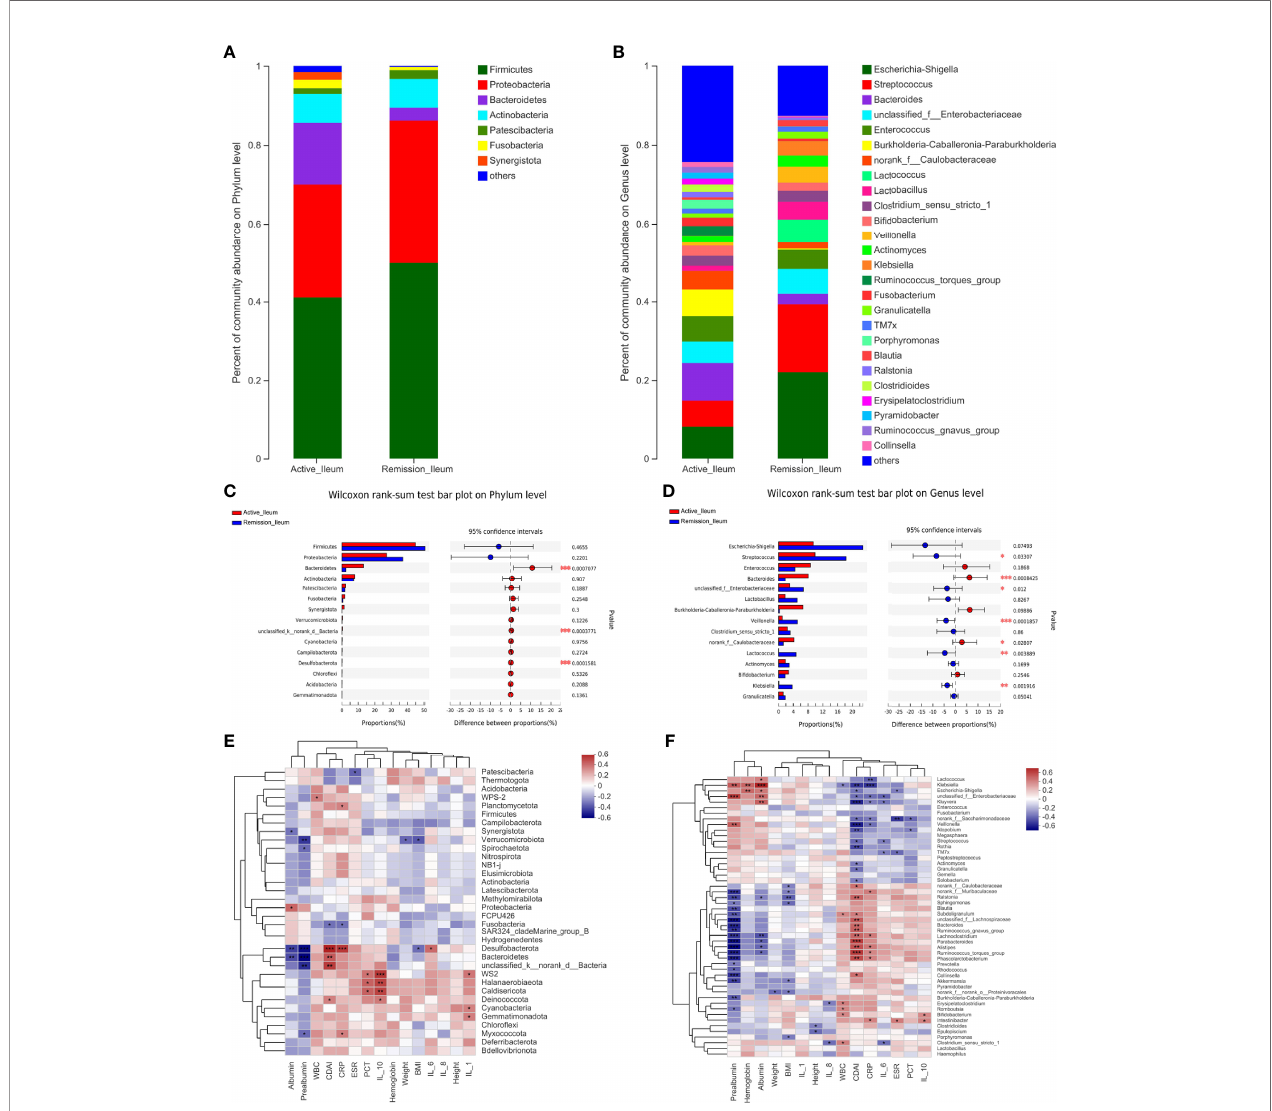
FIGURE 7 | Structure analysis of the ileal microbiota in patients with CD. (A, B) Barplot of the relative abundances of different taxa on the phylum and genus levels, respectively. (C, D) Wilcoxon rank-sum test bar plot of different taxa on the phylum and genus levels, respectively. (E, F) Heatmap revealing the association between ileal microbiota and clinical factors on the phylum and genus levels, respectively. *, **, and *** correspond to p-values <0.05, 0.01, and 0.001,